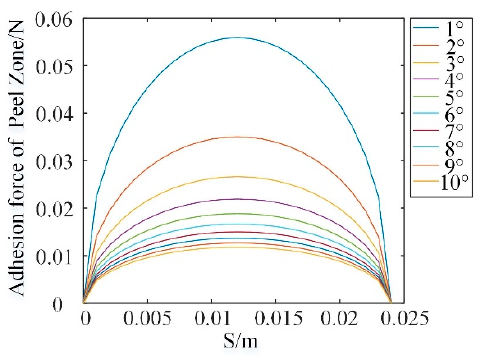
Figure 10. Adhesion force of the peel zone vs blade displacement, S, with peel angle from 1° to 10°.